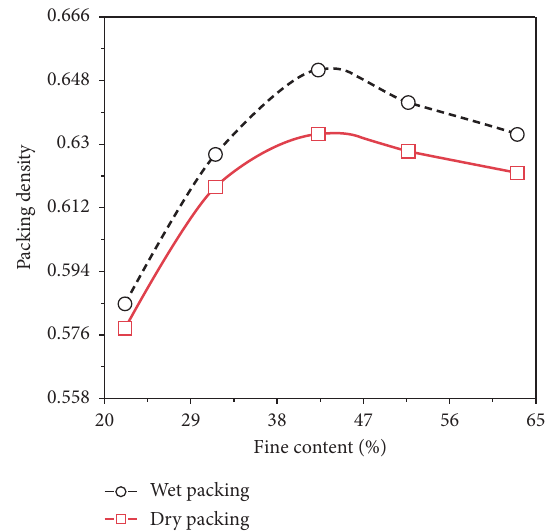
Figure 4: Results of the packing density measured by different